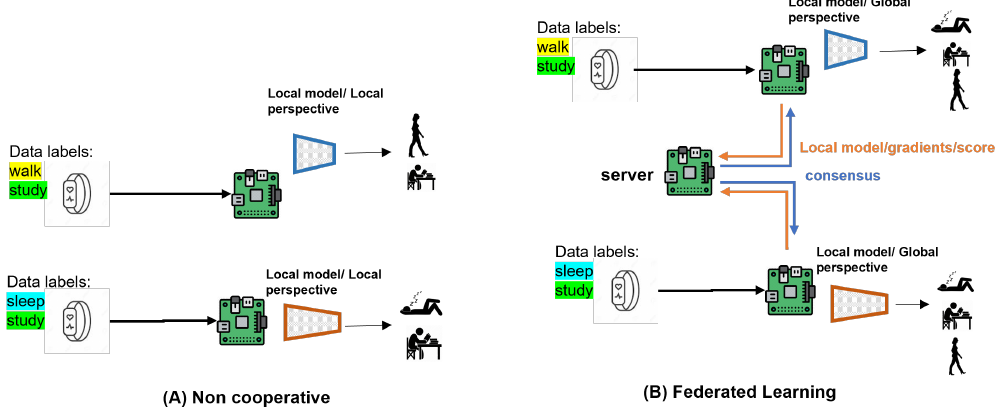
Figure 1. Non-cooperative local training produces local models with limited performance due to limited local training data. Federated Learning gives participating clients a holistic view of the combined data without explicitly sharing it, allowing a model to predict labels unseen in its train data. We go a step further in this work, collaboratively training models with independently designed model